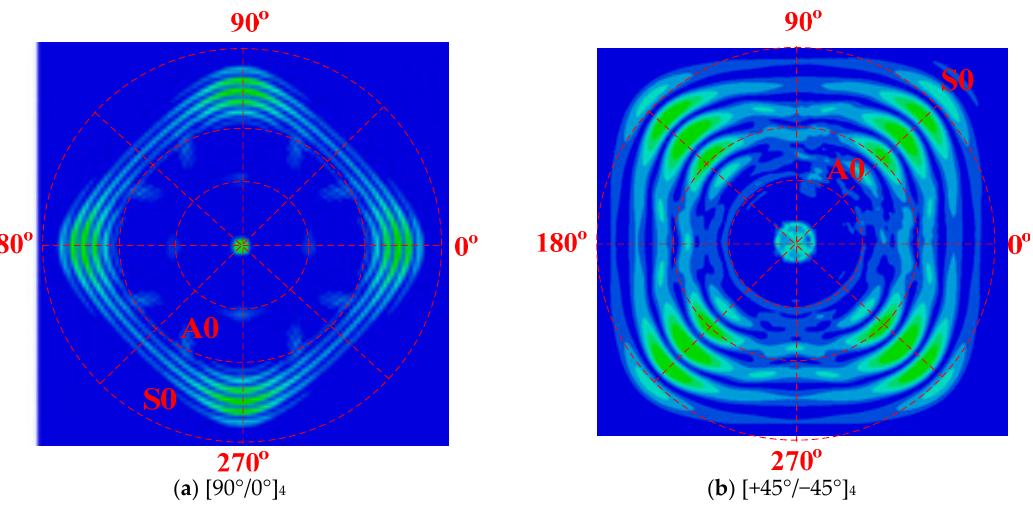
Figure 14. Slowness profiles of S0 and A0 modes in WGF/epoxy composite laminates with different ply modes.